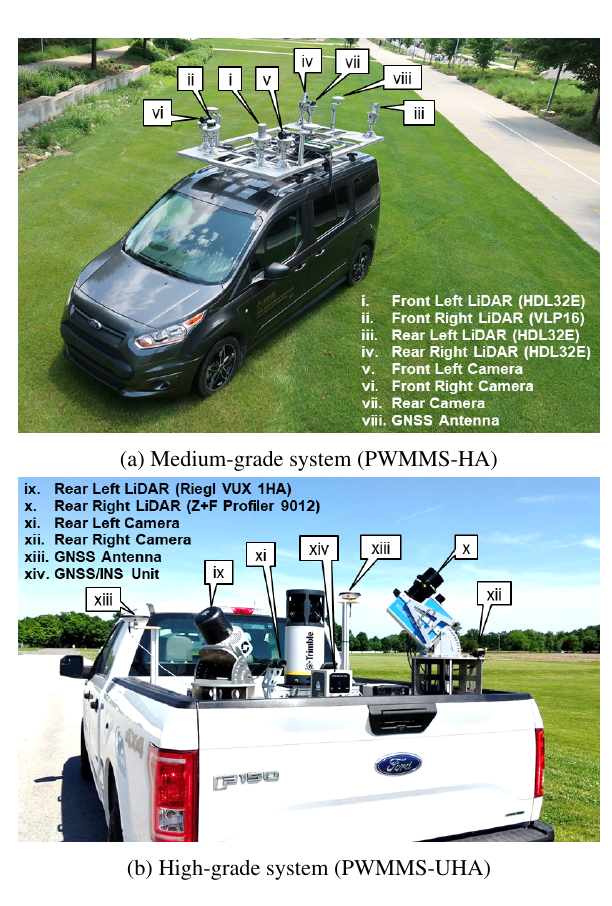
Figure 1: Purdue wheel-based mobile mapping